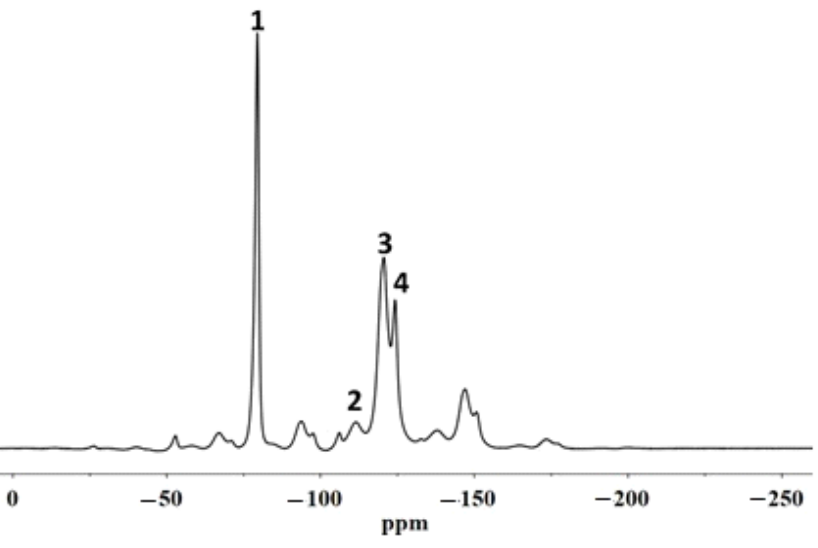
Figure 9. 19 F MAS NMR spectrum of Fluo AQ film. Table 4. Assignment of the chemical shift 19 F MAS NMR spectrum.